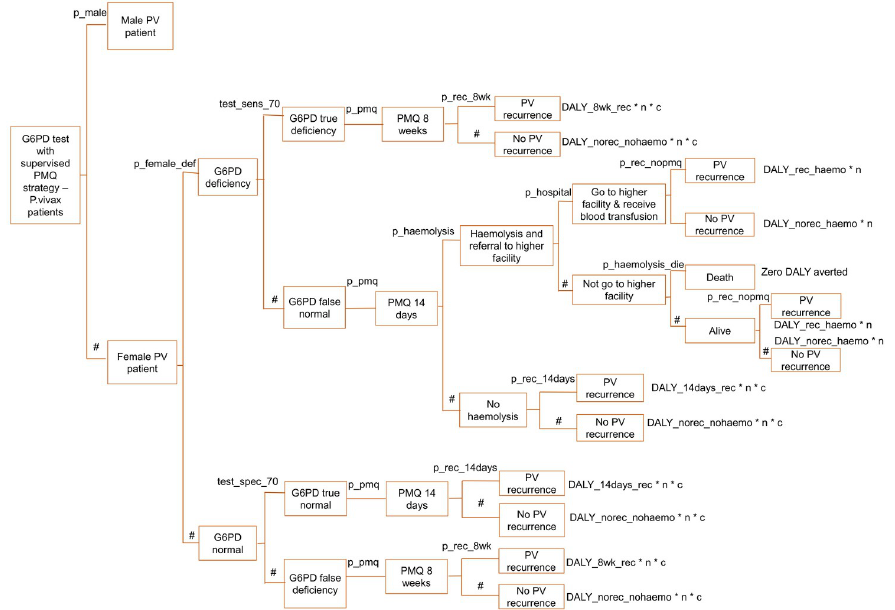
Fig 6. Decision tree model for G6PD test with supervised PMQ strategy—Female